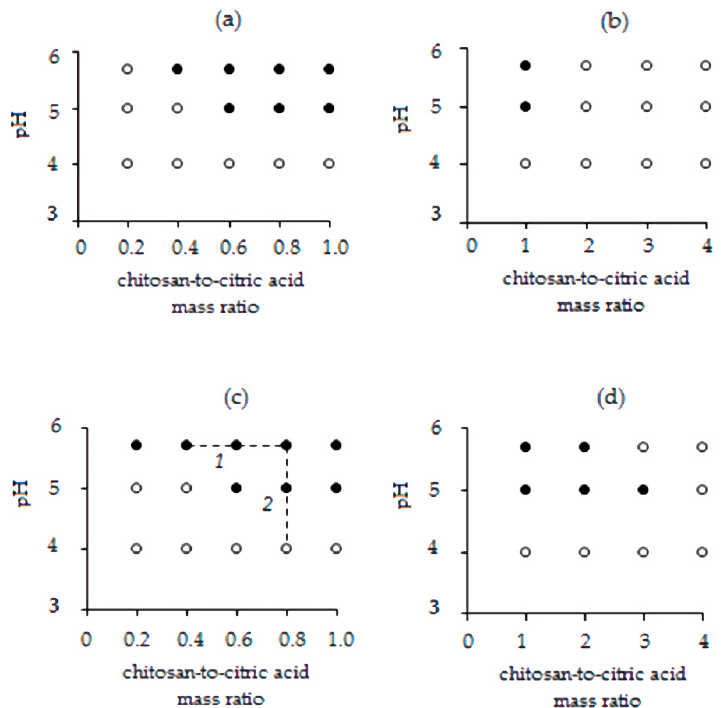
Figure 1. The effect of the chitosan-to-citric acid mass ratio and of pH of the polymer stock solution on the formation of the chitosan–citric acid complex at 20 °C ( a , b ) and 60 °C ( c , d ). Filled symbols ( ● ) denote phase-separated systems, and open symbols ( ○ ) denote homogeneous systems.